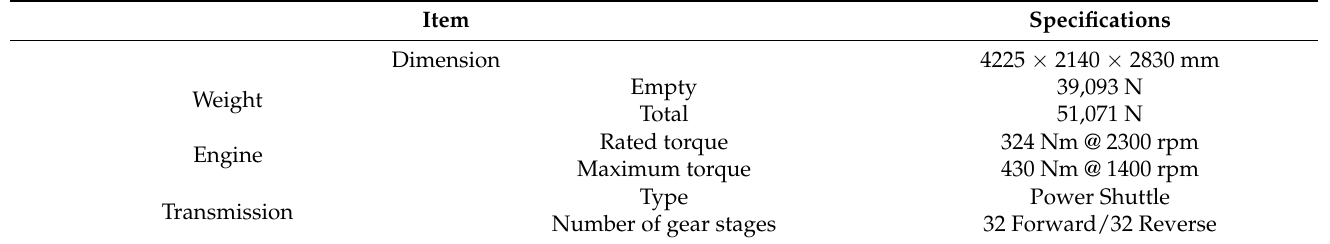
Table 1. Specifications of 78 kW agricultural tractor used in this study.